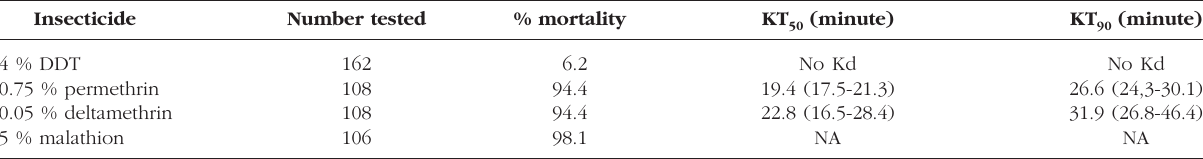
Table I. – Results of WHO diagnostic tests with Anopheles pharoensis from Gorgora, northern Ethiopia. them were alive at the end of the test suggesting the presence of physiological resistance (Table II). Simi-